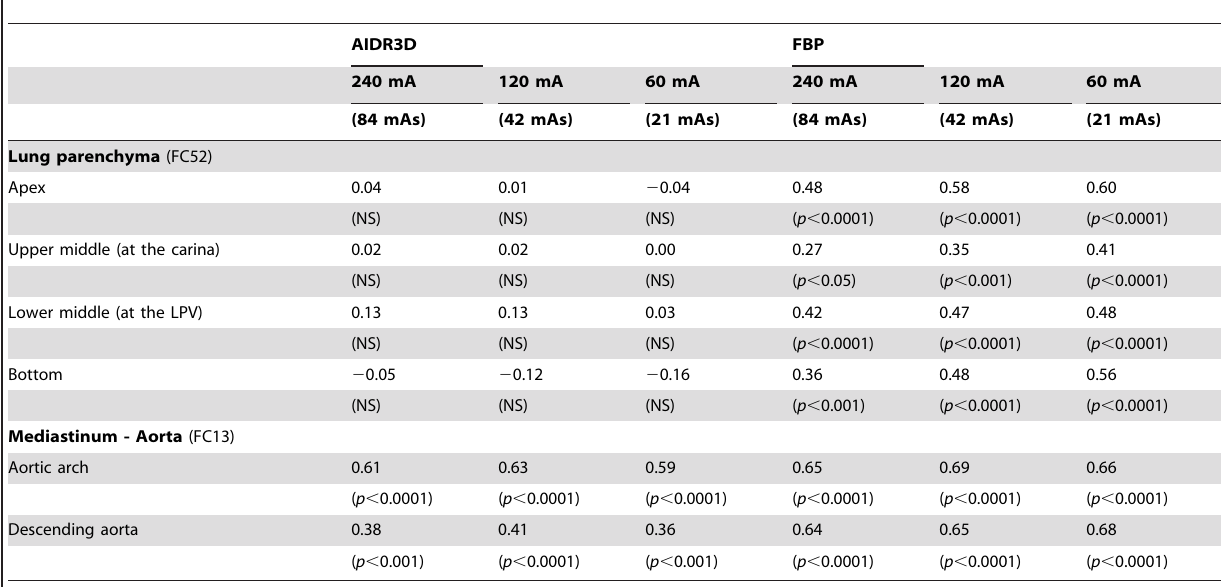
Table 4. Correlations between quantitative image noise and body